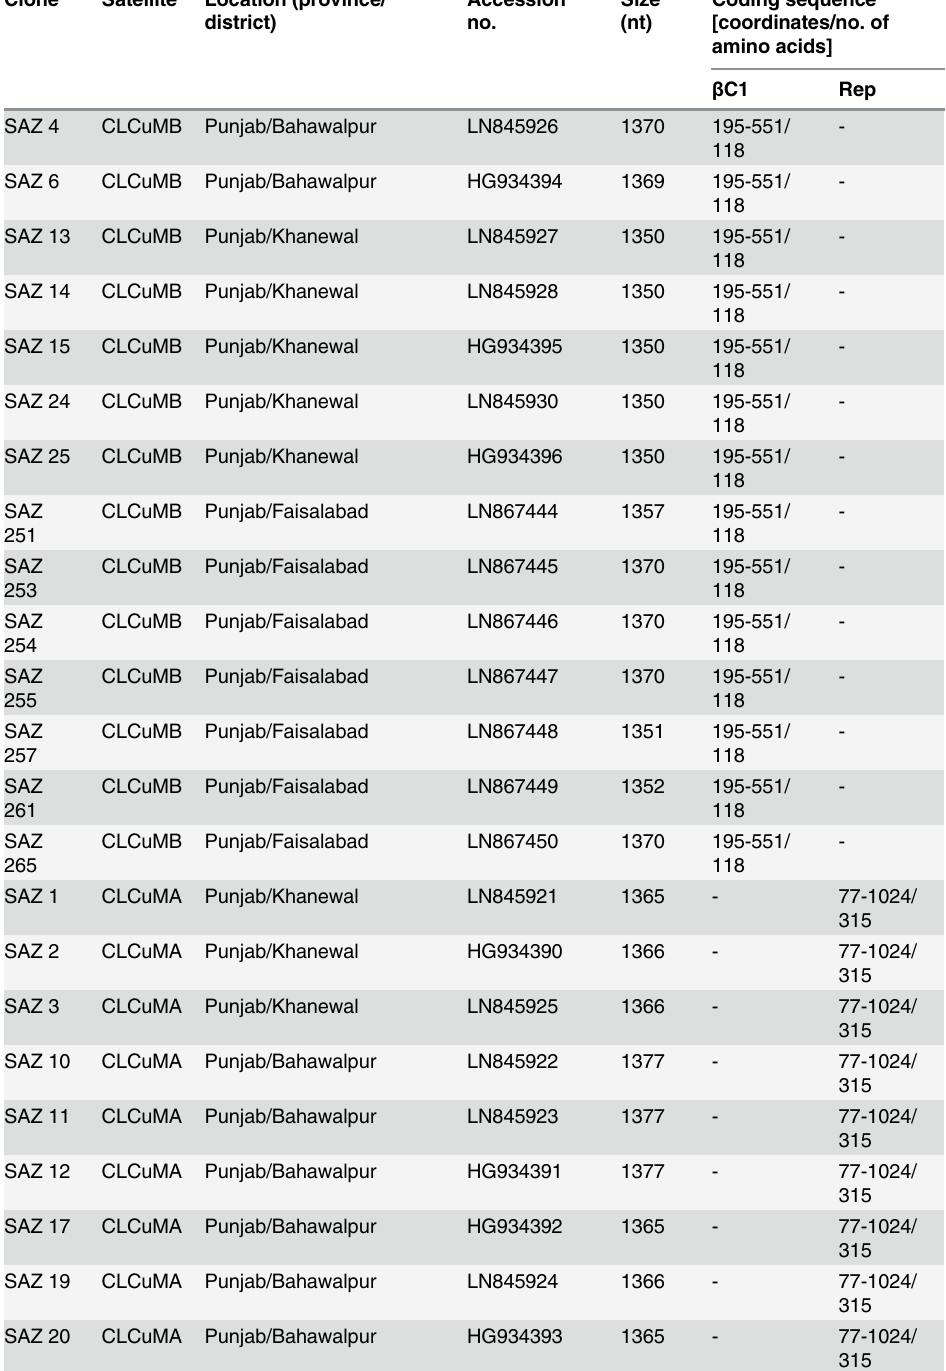
Table 4. Origins and features of alphasatellite and betasatellite clones